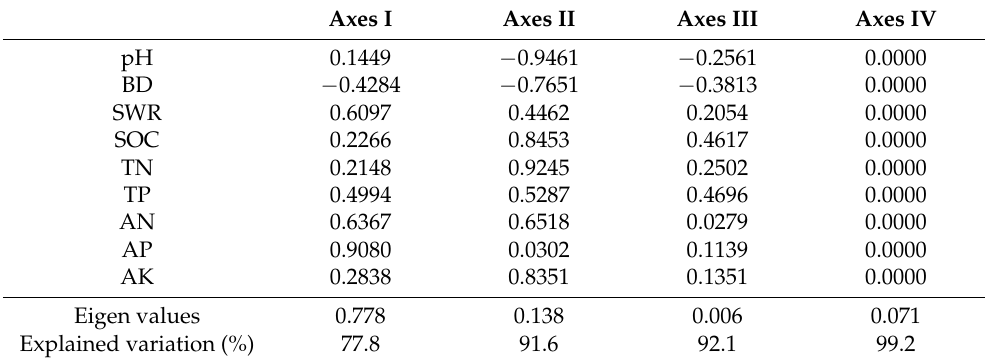
Table 4. Correlation of soil physicochemical factor with the axes by redundancy analysis (RDA) in APR